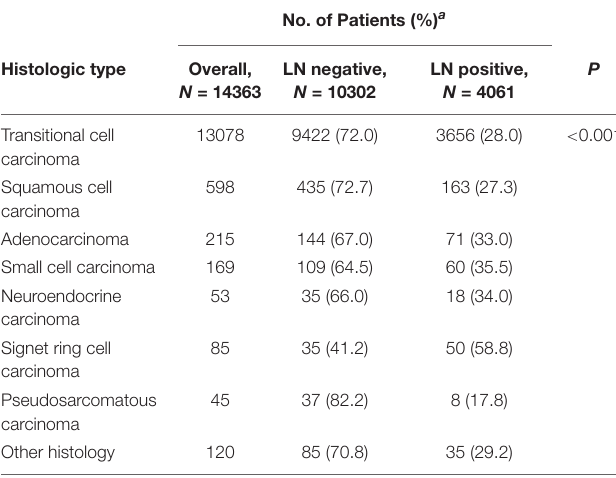
TABLE 1 | Demographic and clinical characteristics of 16,880 patients undergoing cystectomy stratified by PLND versus no PLND within the SEER between 2004 and 2015.